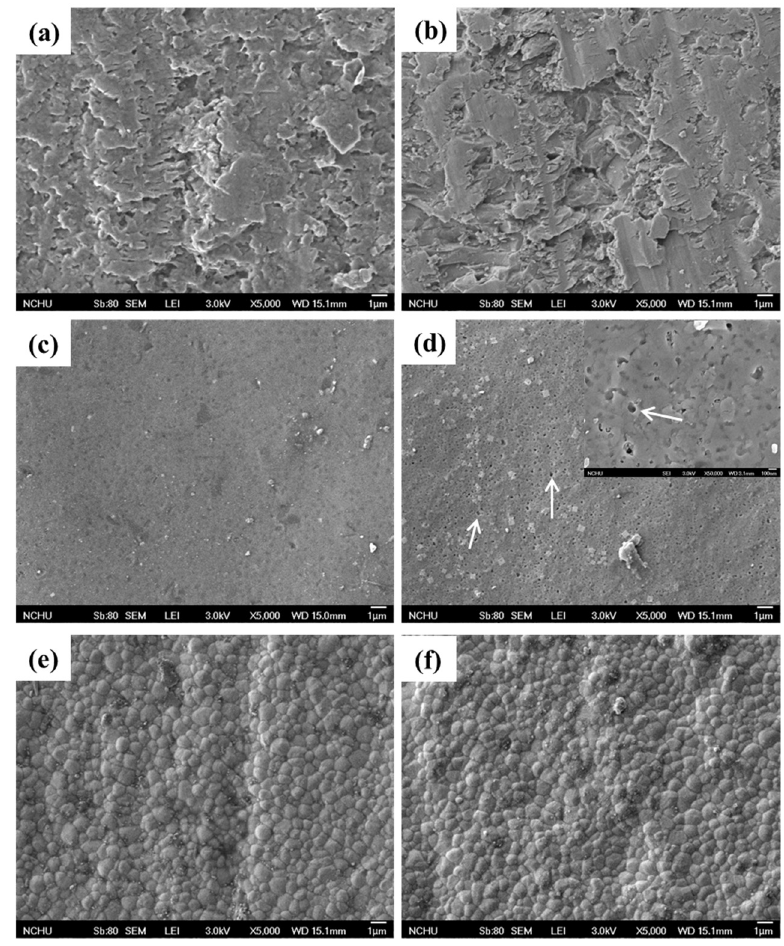
Figure 2. Surface micrographs of ProCAD ( a , b ), IPS e.max CAD ( c , d ) and IPS e.max ZirCAD ( e , f ) before ( a , c , e ) and after ( b , d , f ) soaking in pH 7 artificial saliva for 90 days. The arrows indicate the pitting pores. Magnification: 5 kx. The insert in ( d ) is a magnified picture with a magnification of 50